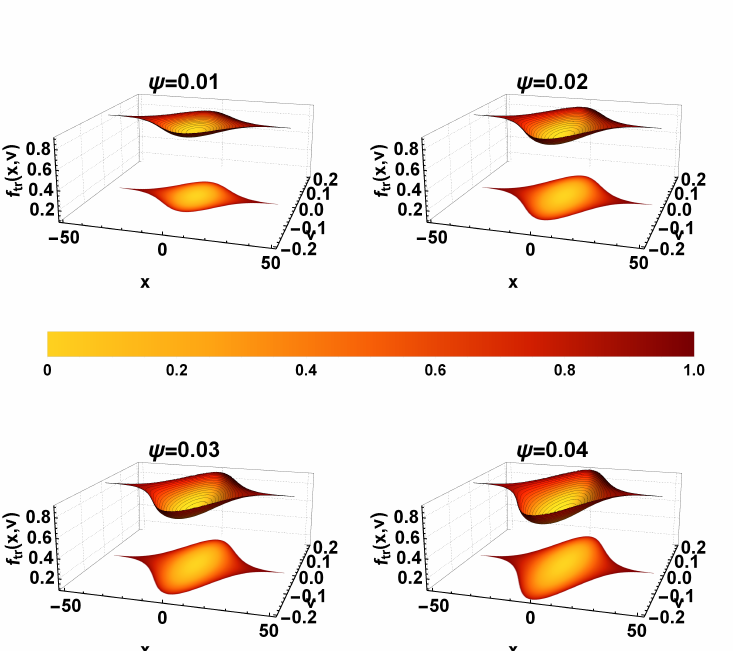
Figure 4. Three-dimensional structure of the trapped ion distribution function f tr ( x , v ) versus x and v , for different values of ψ , while keeping T r = 0.5 and δ = 10 as fixed. The color bar indicates the density. The two-dimensional projection of f tr ( x , v ) is displayed underneath the surface plot of the trapped ion distribution function.